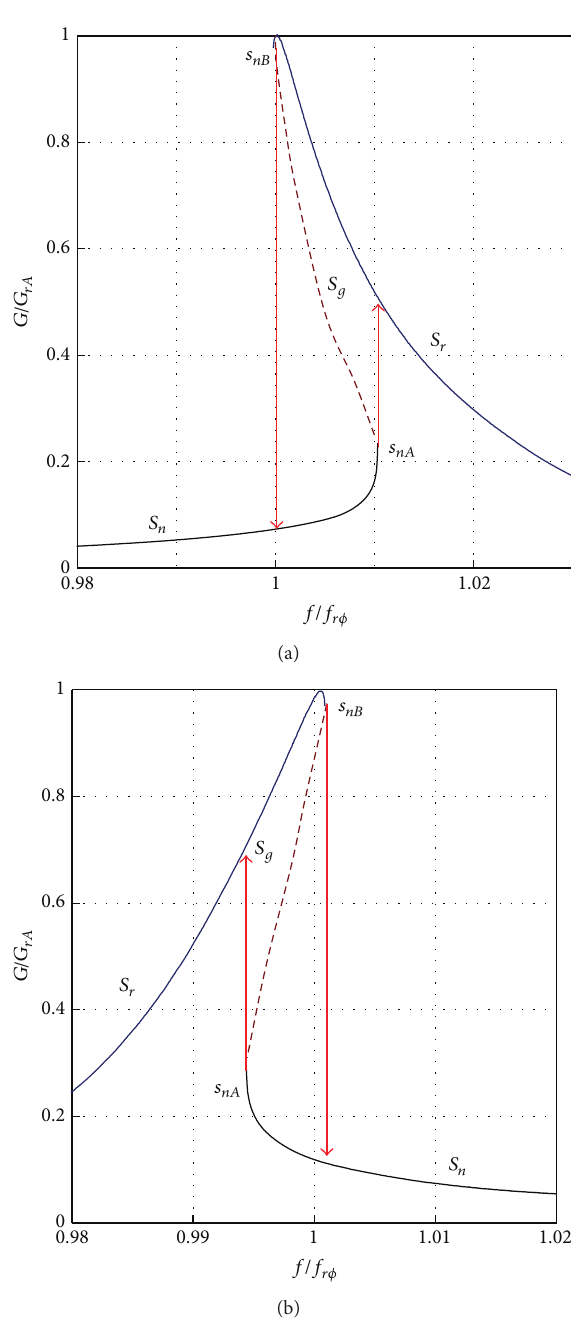
Figure 28: Shape of resonance characteristic for cracked blade with: (a) material weakening on the crack tip; (b) material hardening on the crack tip [3,